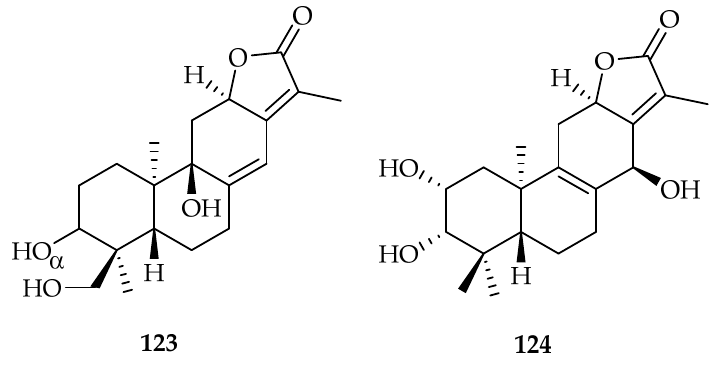
Figure 50. Structures of tripterregeline A 121 [74] and trigohowimine A 122 [75]. HL-60, SMMC-7721, A54, MCF-7, and SW480 cell lines, with IC 50 values of 0.82, 2.65, 5.64, 6.26, and 8.53 µ M, respectively, better than the positive control cisplatin [75] (Figure 50). A phytochemical investigation on the aerial part of Euphorbia helioscopia Linn. (Euphorbiaceae) led to the isolation of 14 highly oxygenated new ent -abietane diterpenoids, euphelionolides A–N [76]. The cytotoxicities of the isolates were evaluated in vitro against MCF-7 and PANC-1 cell lines via the MTT method. Paclitaxel and gemcitabine were used as positive controls. The results showed that only euphelionolides F 123 and L 124 had significant cytotoxic activity against the MCF-7 (IC 50 9.5 and 9.8 µ M, respectively) and PANC-1 (IC 50 10.7 and 10.3 µ M, respectively) cells. However, compounds analogues of 123 and 124 did not exhibit significant cytotoxic effects; the structure–activity relations of the Euphorbia diterpenoids results are still unclear (Figure 51).